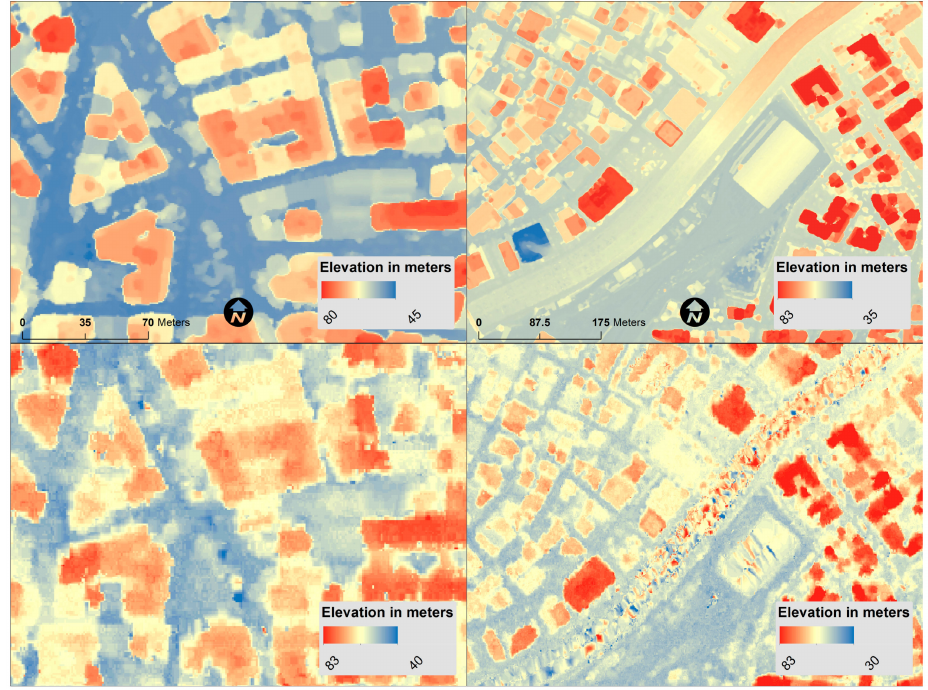
Figure 5. Details in the cityscape of Athens in the level of neighborhood from the reference dataset (above) and the produced DSM (below).